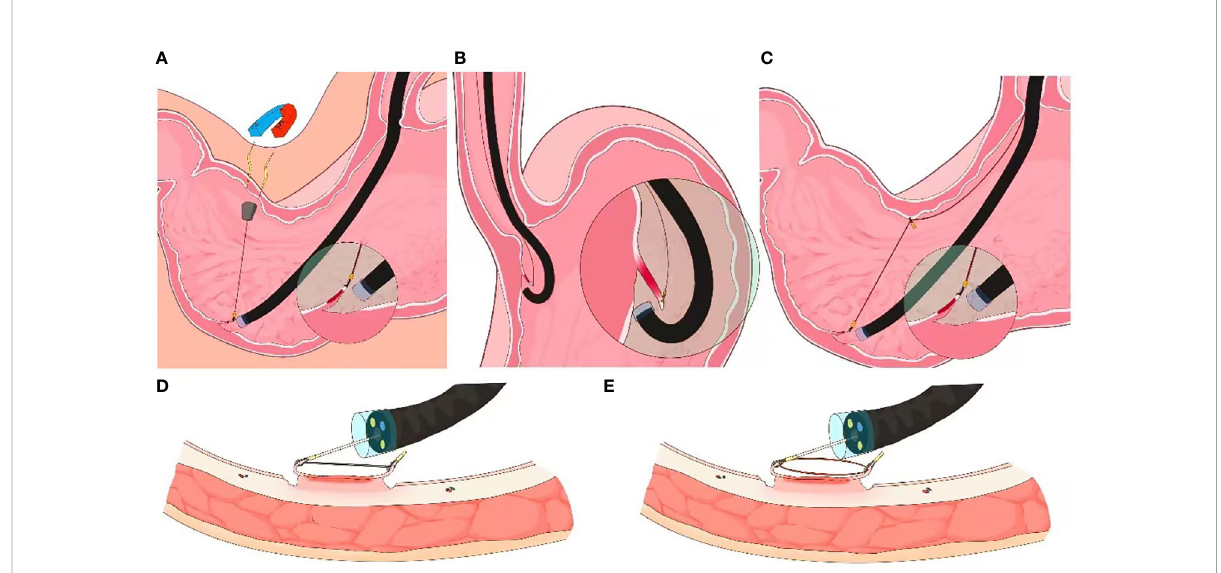
FIGURE 2 External endoscopic resection techniques. (A) Schematic of magnet-anchor traction technique ((from Gotoda et al). (B) Schematic of clip-line traction technique. (C) Schematic of pulley clip-line traction technique (D, E) Schematics of clip-snare traction